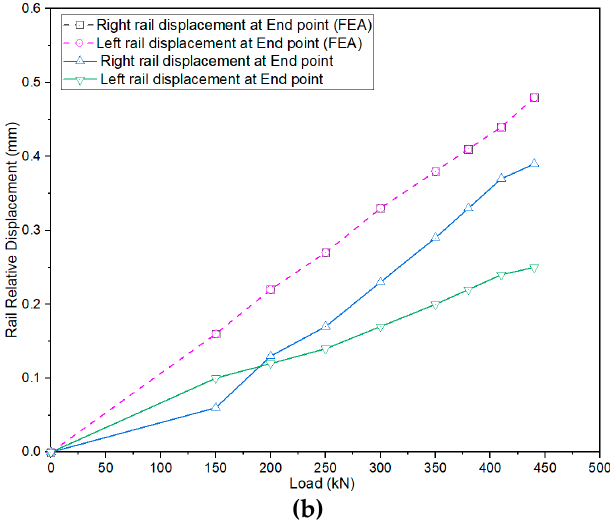
Figure 11. Comparison of rail relative displacement (Load case I), ( a ) at center point, and ( b ) at end point.